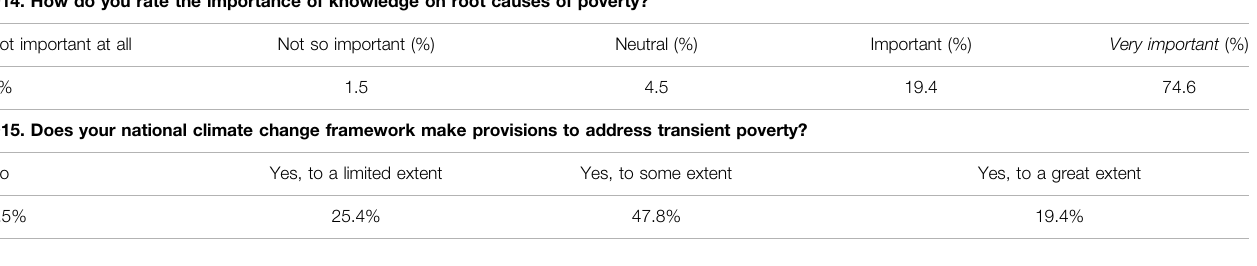
TABLE 3 | Results on questions regarding poverty.